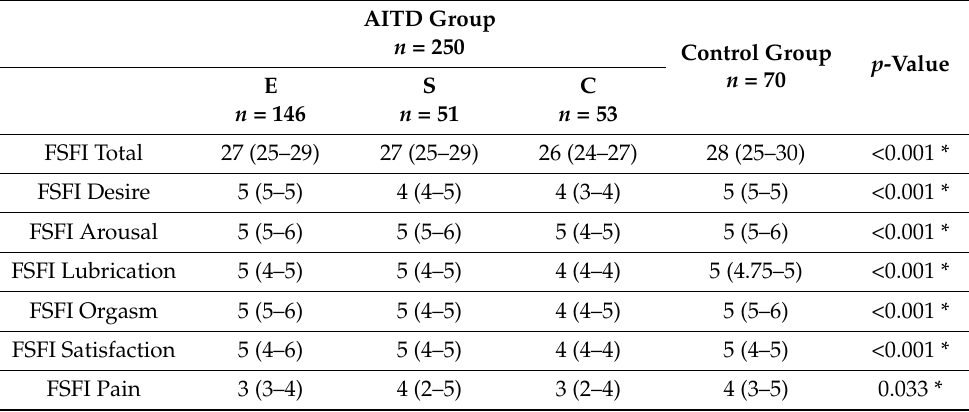
Table 6. Comparison between categories of AITD and healthy patients in terms of FSFI scores by separate domains.